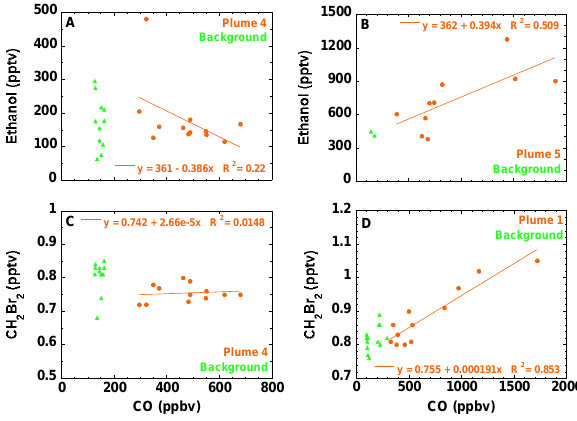
Figure 11. Ethanol mixing ratios in (a) Plume 4 and (b) Plume 5, and CH 2 Br 2 mixing ratios in (c) Plume 4 and (d) Plume 1, which shows their high plume-to-plume variability. Green triangles = background air; orange circles = smoke plumes.